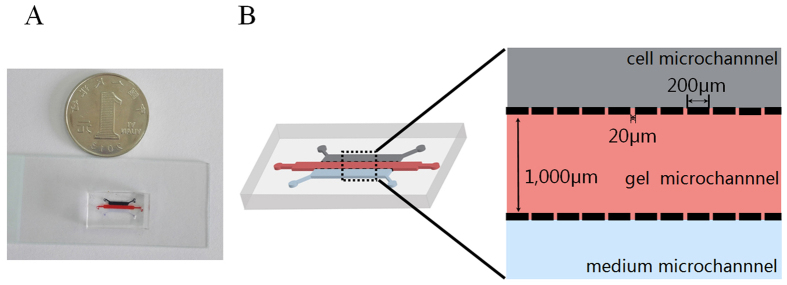
Photograph (A) and illustration (B) of the home-made microfluidic chip. The chip comprises two side micro-channels sandwiching a gel micro-channel with two rows of micro-gaps. The gel micro-channel was filled with Matrigel (red), and the cell micro-channel and medium micro-channel were used for plating the cells (black) and the chemoattractant (20% FBS) (blue), respectively.